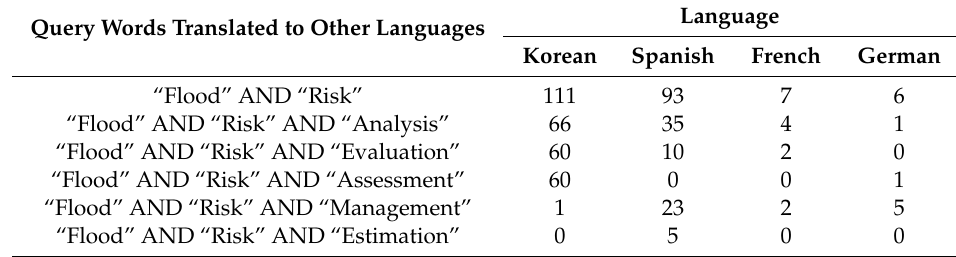
Table 2. Number of records of FRA terms in WoS databases translated to the other main languages (updated at 22 June 2020).